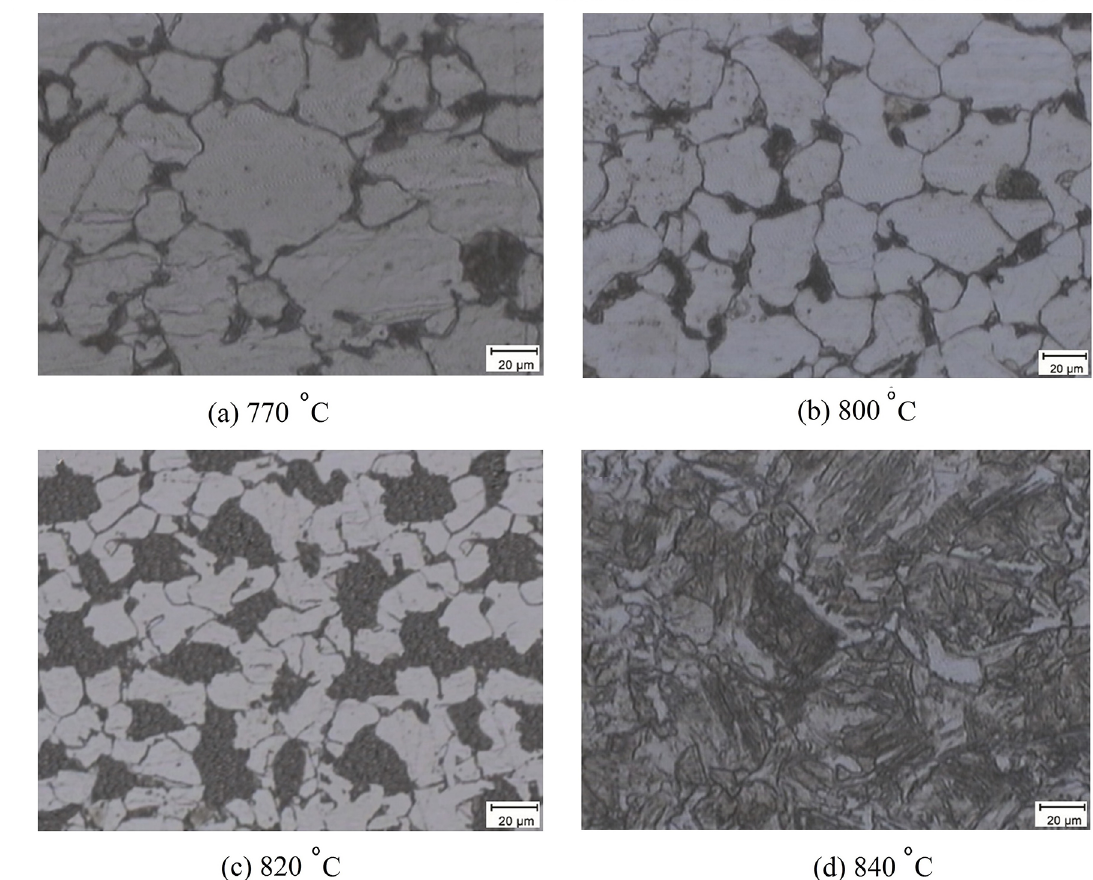
Figure 2. Optical micrographs of the heat-treated samples at various intercritical temperatures. showing light ferrite areas and dark pearlite/ martensite areas.